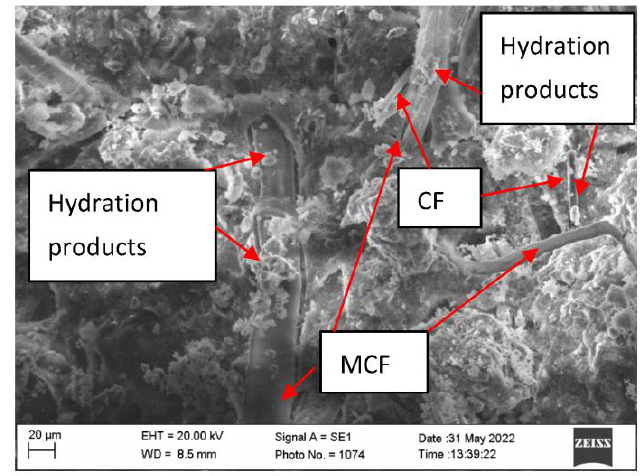
Figure 8. Microstructure of the sample AP050.